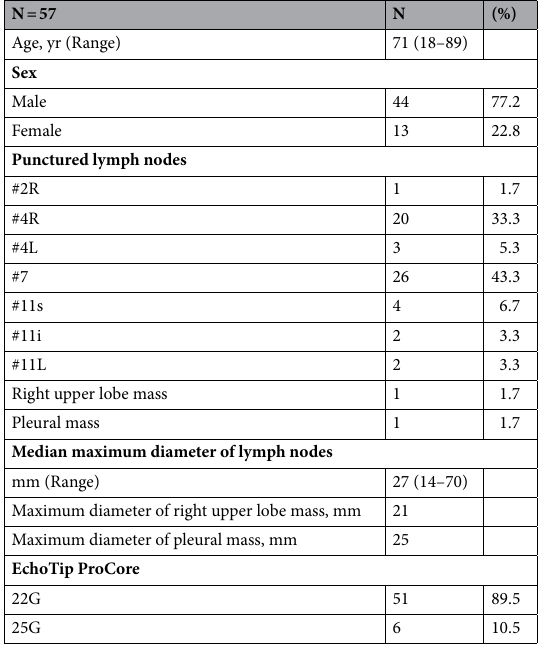
Table 1. Patients characteristics. Baseline demographic and clinical characteristics of 57 patients who underwent EBUS-TBNA with EchoTip ProCore between June 2017 and February 2020.